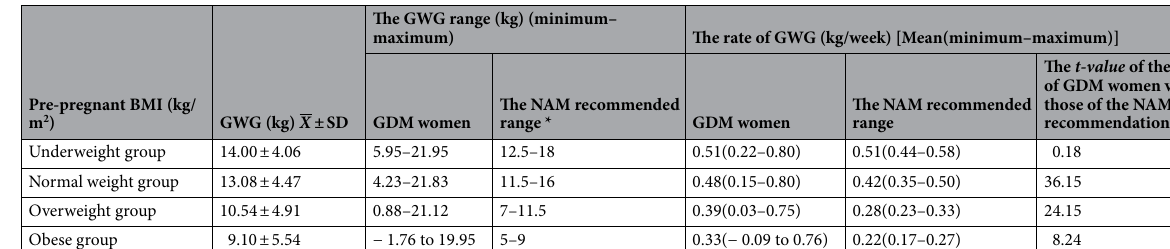
Table 2. Comparisons of the GWG in Chinese women with GDM with the NAM recommendation (n = 14,578). BMI body mass index, GWG Gestational weight gain, GDM gestational diabetes mellitus. *The values were recommended by the National Academy of Medicine guidelines in 2009.